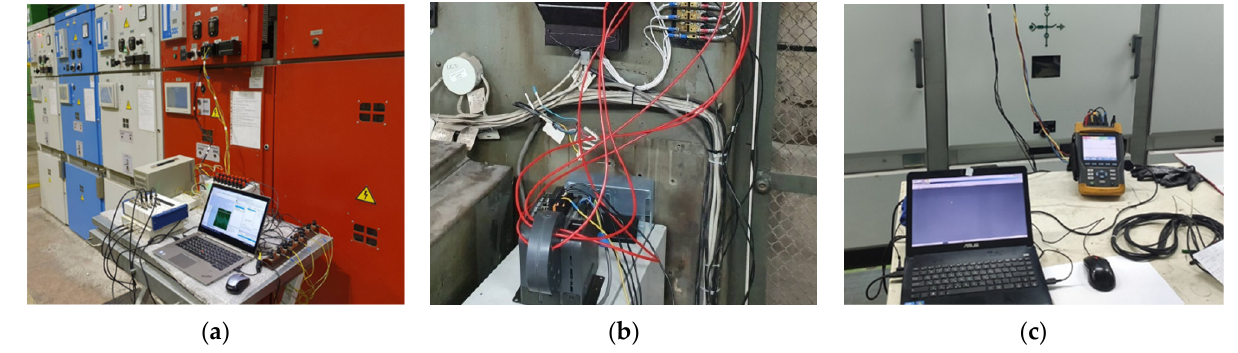
Figure 9. Measuring complexes to analyze the power quality in the internal power grid of metallurgical enterprises based on high-speed multichannel electrical signal recorders: ( a ) ProsoftSystem ‘EER-3’ (Russian «P Э C-3 П p о c оφт -C и c т e мы ») (sampling frequency of 100 kHz; instrument error, ± 1%) and National Instruments NI-USB-6251 (sample rate maximum, 1.25 MS/s; accuracy, ±1%); ( b ) power quality analyzers Elspec G4420 (voltage harmonics up to 255; uncertainty, 0.1% of Nominal); ( c ) Fluke 435 (sampling frequency of 200 kS/s) and Fluke i5s current clamps (useable frequency 40 Hz to 5 kHz; accuracy, ±1%).